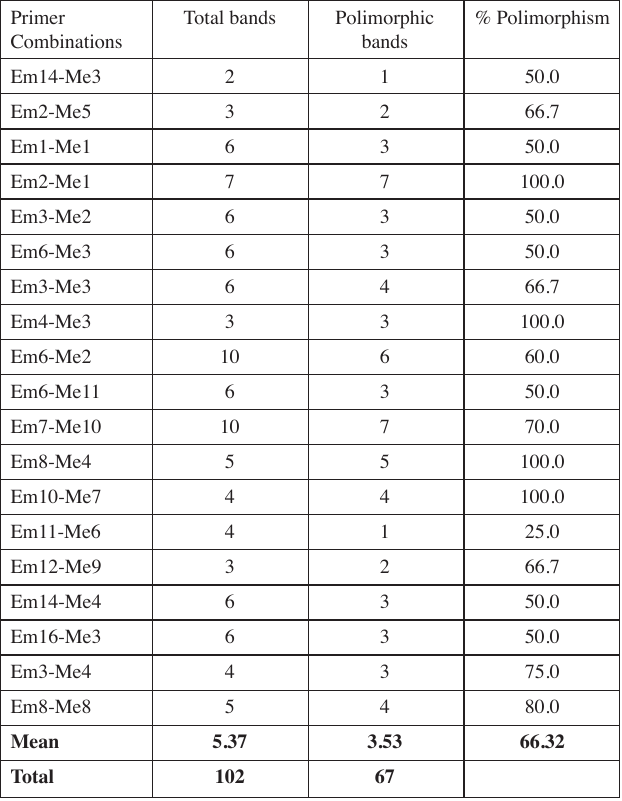
Tab. 2: Observed polymorphism with 19 SRAP primer combinations in 4 banana clones.